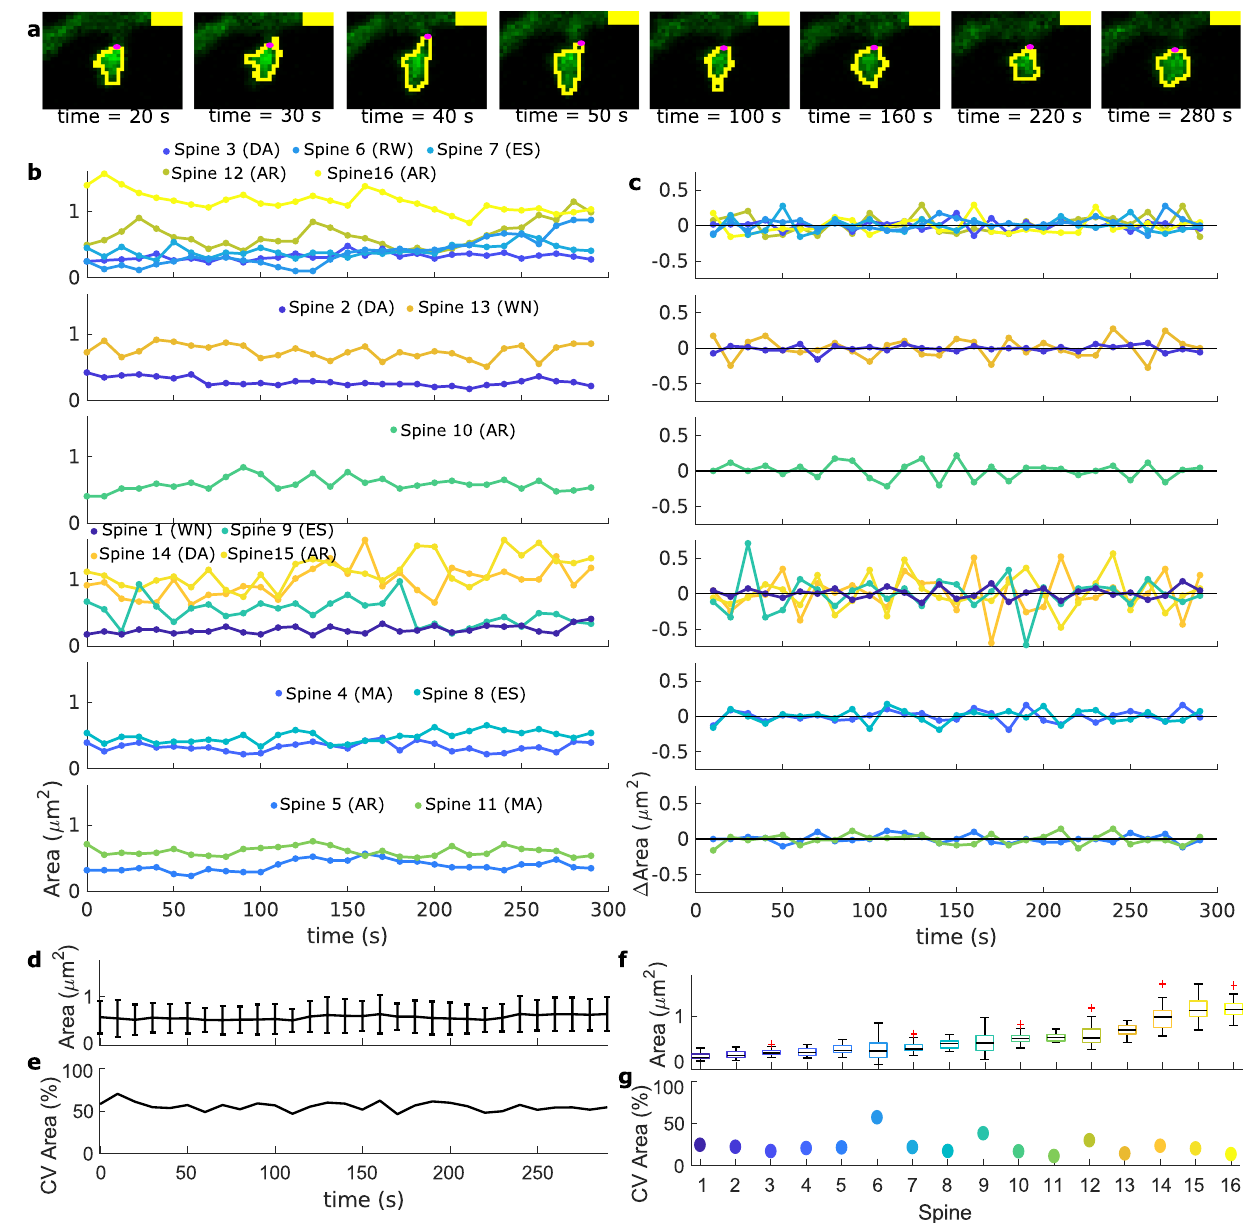
Figure 2. Spine area evolution over time from a population data set. ( a ) Images taken from time-lapse data of a neuron transfected with GFP-actin (green). The yellow polygon represents the analysed ROI and the magenta circle corresponds to the spine neck center. Yellow bar indicates 1 µ m. ( b ) Area evolution for spines in different stacks (top to bottom). Spines are color-coded and numbered from small (dark blue) to large (yellow). Abbreviations correspond to the best fit of an ARIMA model (see Supplementary Information, Table S1). ( c ) Difference of area, (cid:31) Area , from spines in ( b ) over time. ( d ) Mean ± standard deviation (std) of the area of the analysed spines at each time-frame. ( e ) Coefficient of variation (CV) from ( d ). ( f ) Boxplots of spine area evolution for each spine. ( g ) CV from ( f